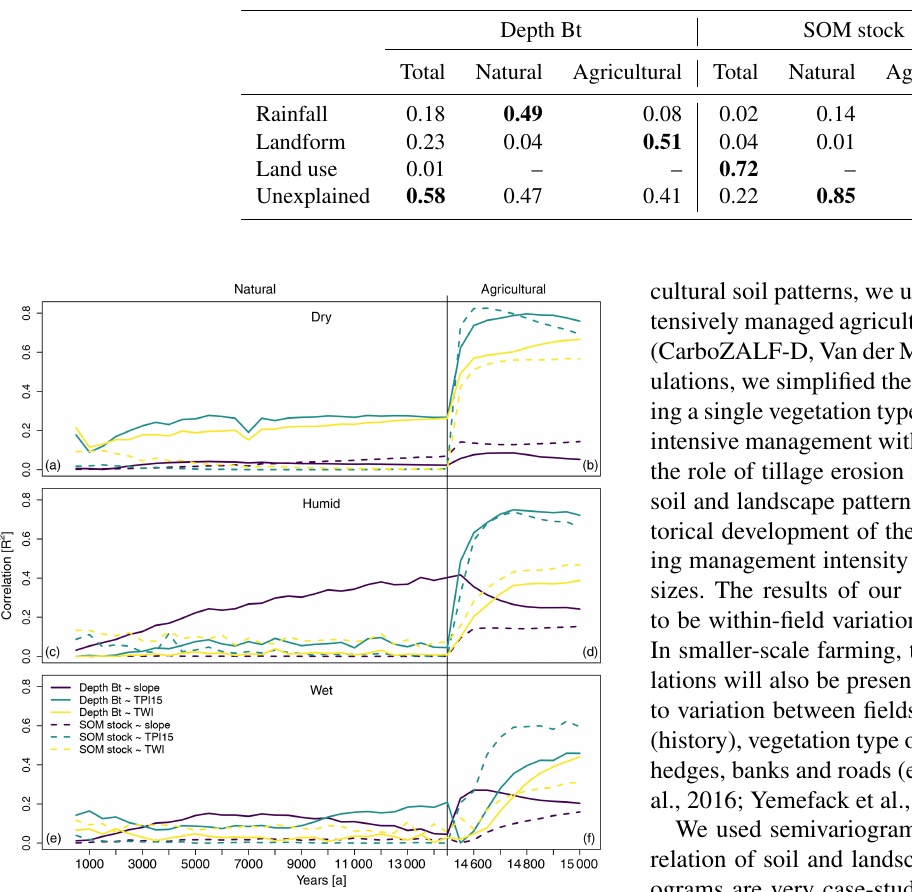
Figure 7. Correlations ( R 2 ) between selected soil properties (line types) and topographic properties (colors) through time (left to right), for the different rainfall scenarios (top to bottom). In the natural system, the correlations are presented every 500 years, while in the agricultural system, the correlations are presented every 50 years. Note that for the latter phase the x axis is